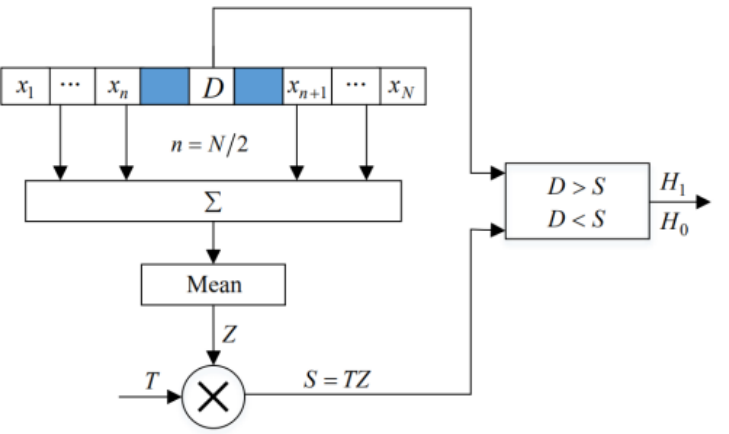
Figure 2. Block diagram of the CA-CFAR detector.